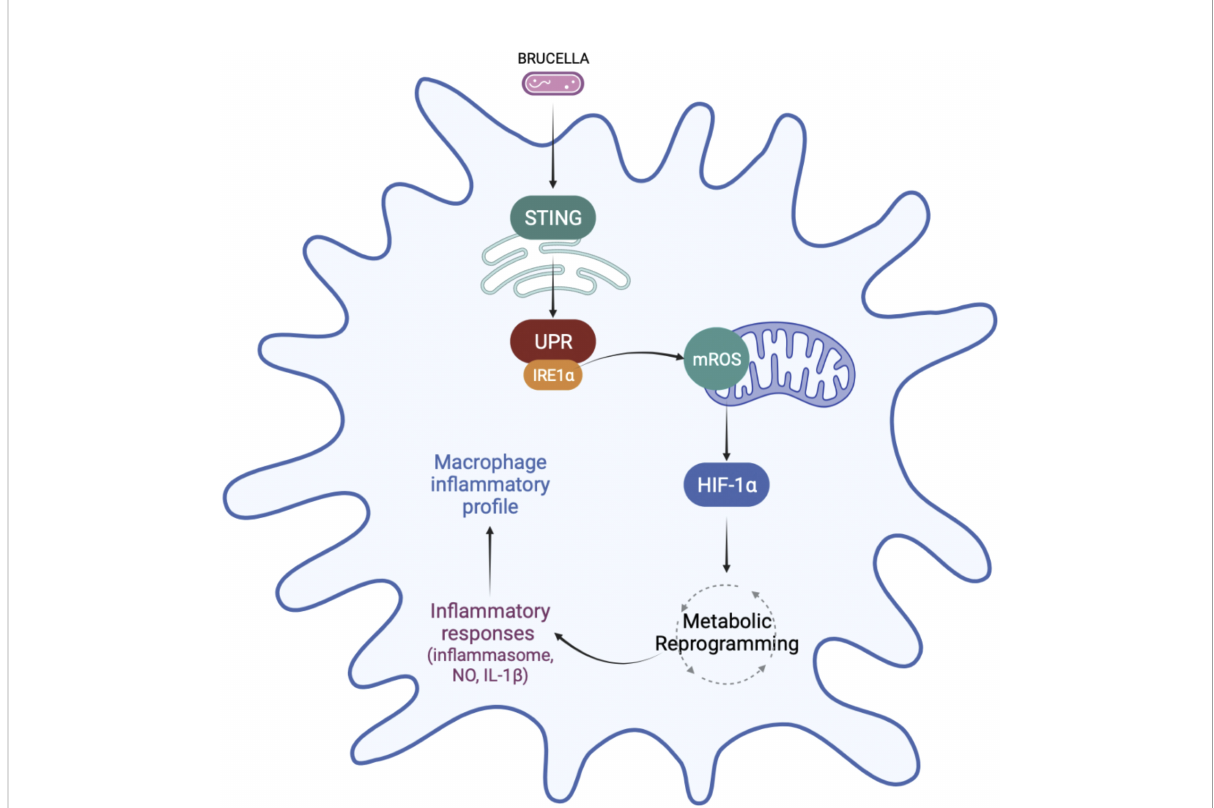
FIGURE 8 Regulation of macrophage metabolic function by IRE1 a in Brucella abortus infection. IRE1 a activation by Brucella abortus triggers mROS generation that induces HIF-1 a stabilization in infected macrophages. IRE1 a drives the metabolic reprogramming in macrophages, contributing to the enhanced glycolysis and reduced OXPHOS observed in Brucella -infected macrophages possibly via HIF-1 a . This IRE1 a -dependent HIF-1 a stabilization is crucial for inducing in fl ammatory responses during infection. IRE1 a induces in fl ammasome assembly, IL-1 b release and NO production, supporting the in fl ammatory pro fi le in macrophages infected with B abortus . Figure created using BioRender